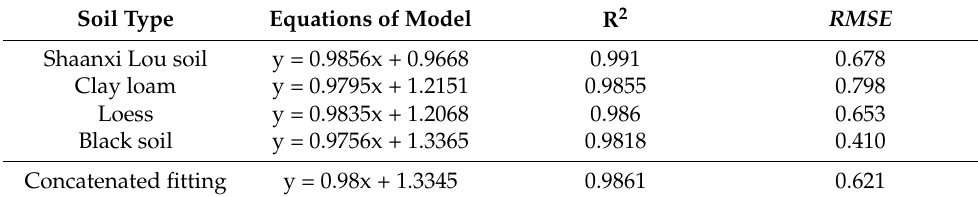
Table 3. Correlation table of four kinds of soil infiltration lines.